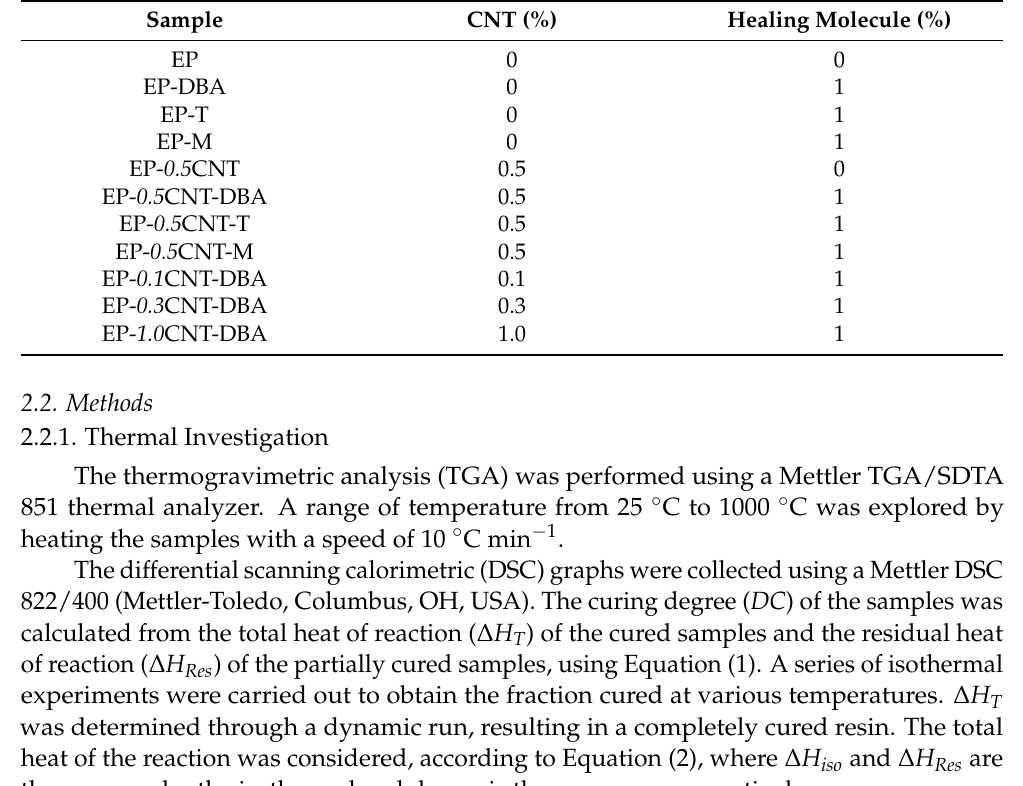
Table 1. Composition and abbreviations of the prepared